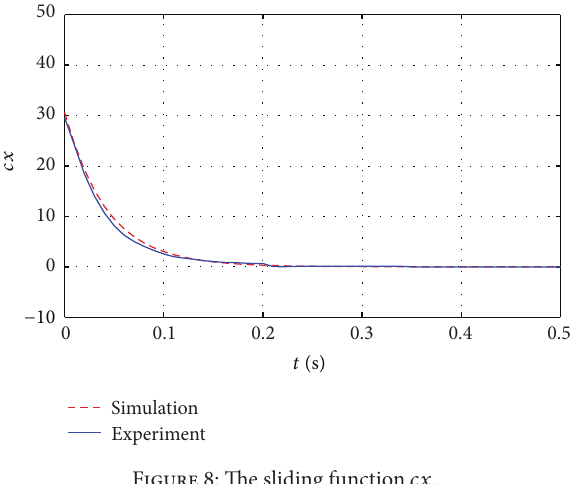
Figure 10: The distance.